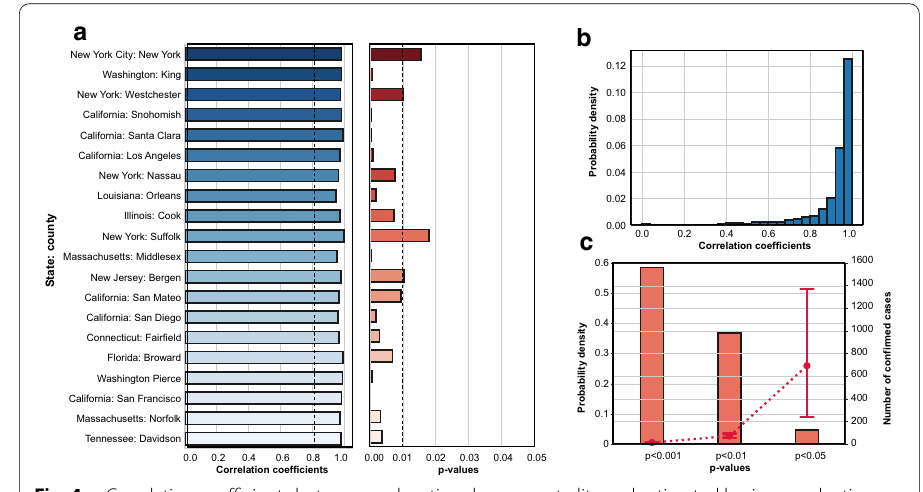
Fig. 4 a Correlation coefficients between co-location degree centrality and estimated basic reproduction number and the p-values for 20 counties with the greatest number of confirmed cases on March 31; b distribution of correlation coefficients for all counties; and c distribution of p-values (orange) for the correlation analysis for all counties. The data for confirmed cases is based on the CDC reports on March 31, 2020 (red). The error bar represents the two-side 95% confidence interval. Some extreme numbers of confirmed cases are considered as outliers and are not